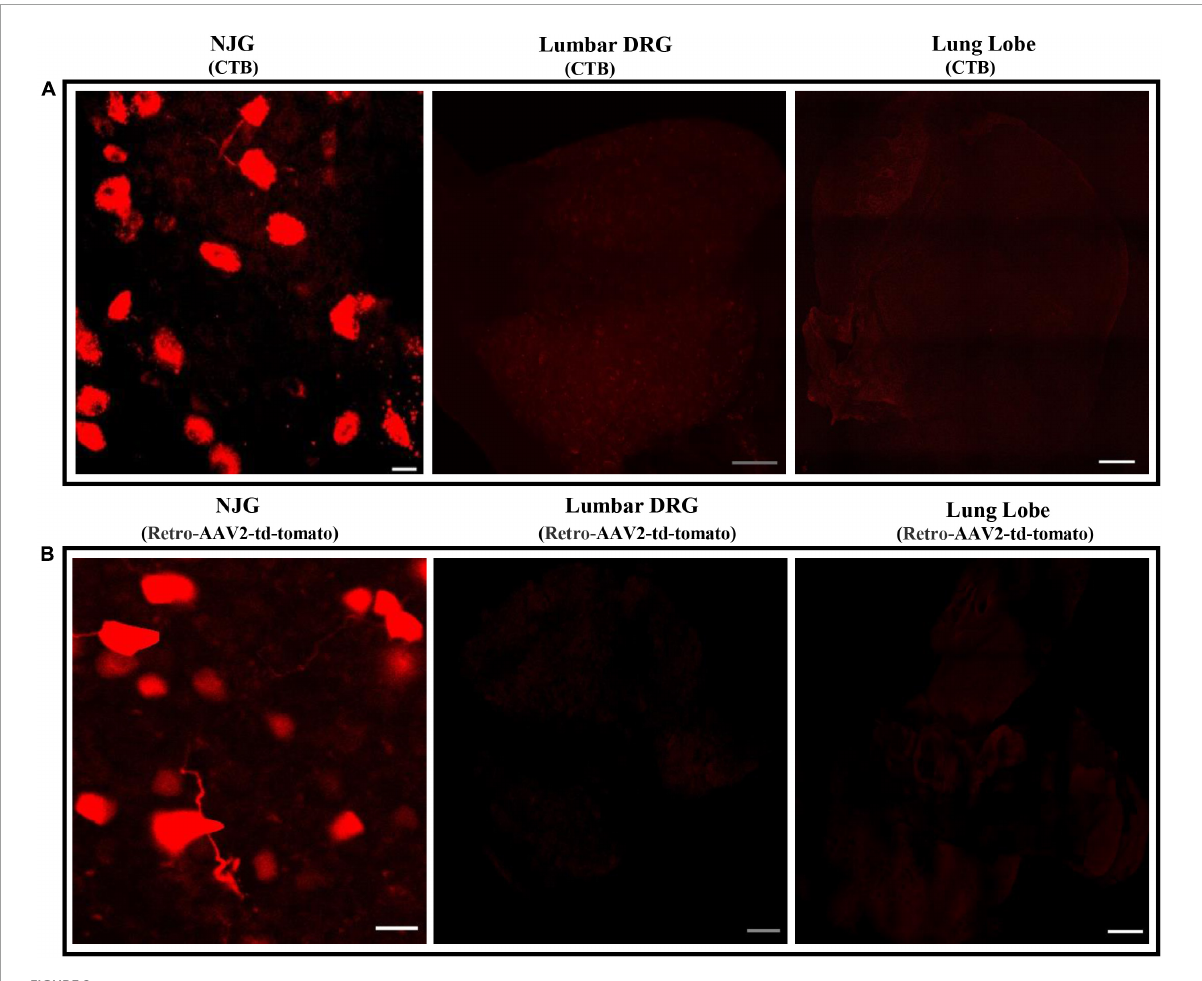
FIGURE2 Absence of neuronal labeling in lumbar DRGs and the lungs following cardiac injections of neurotracers. (A,B) The lungs, lumbar DRGs, and NJG were isolated from mice after CTB ( n = 3) or cardiac retro-AAV2-td-tomato ( n = 3) injections and maximum intensity projections were imaged. While neuronal labeling in the NJGs was clearly observed, no labeling of neurons or nerves was seen in the lungs (confirming lack of leakage of dye) or in the lumbar DRGs (confirming lack of significant leakage into the systemic circulation). NJG: Bars = 20 µ m. Lumbar DRGs: Bars = 100 µ m. Cleared lung tissue: Bars = 500 µ